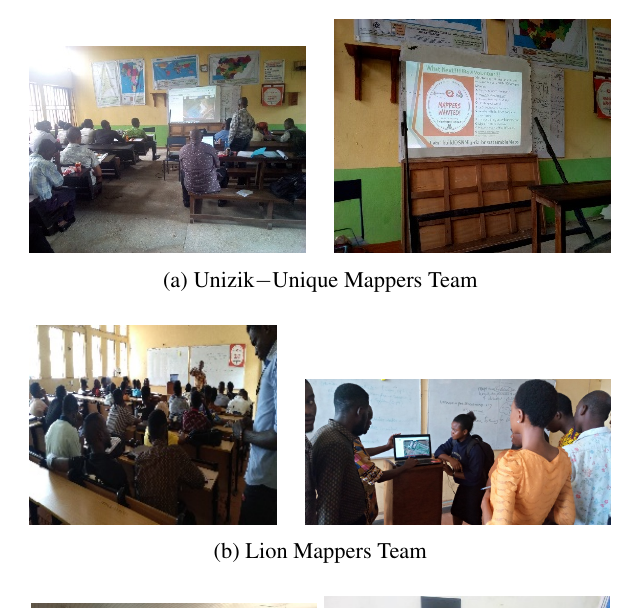
Figure 5: Tai LGA delineated HOT Tasking Manager Project